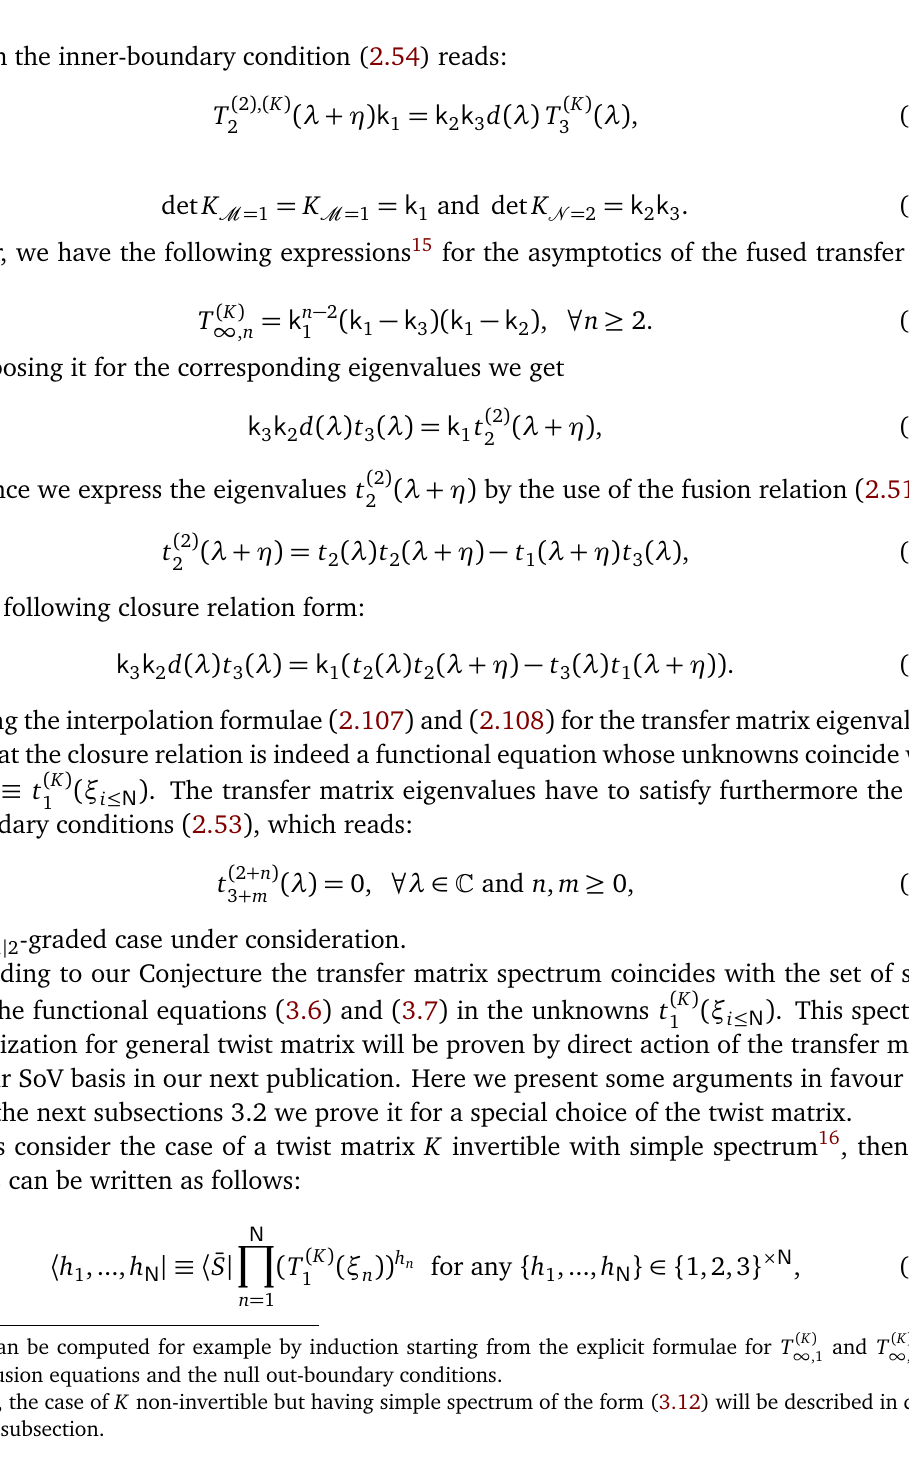
Figure 3: Admissible domain for Young Diagrams of gl